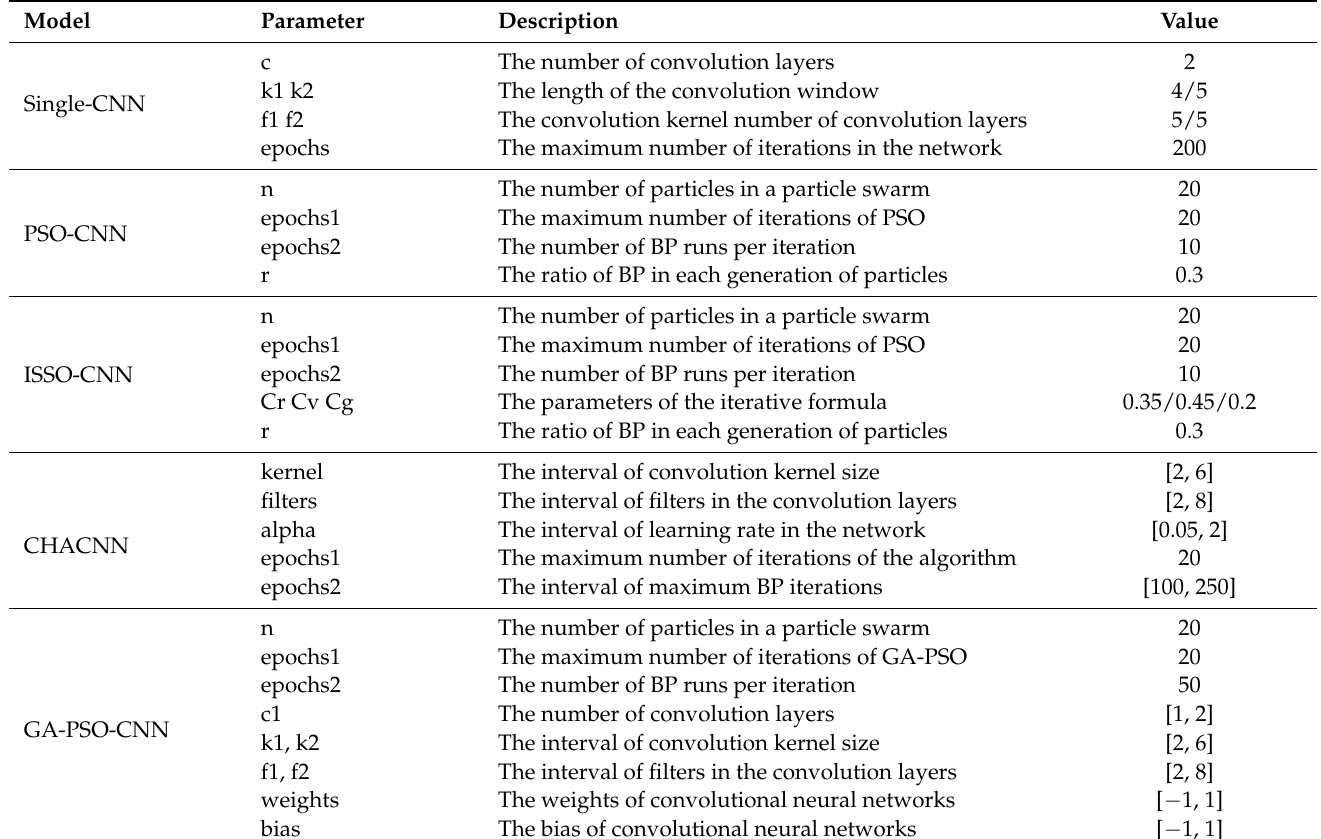
Table 2. Parameter values for different models.